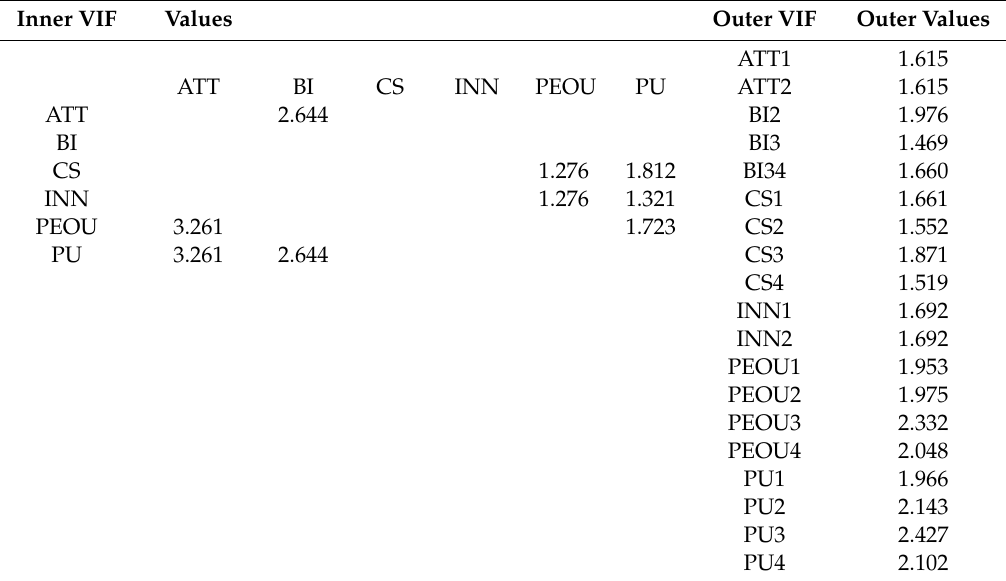
Table 5. Variance Inflation Factor